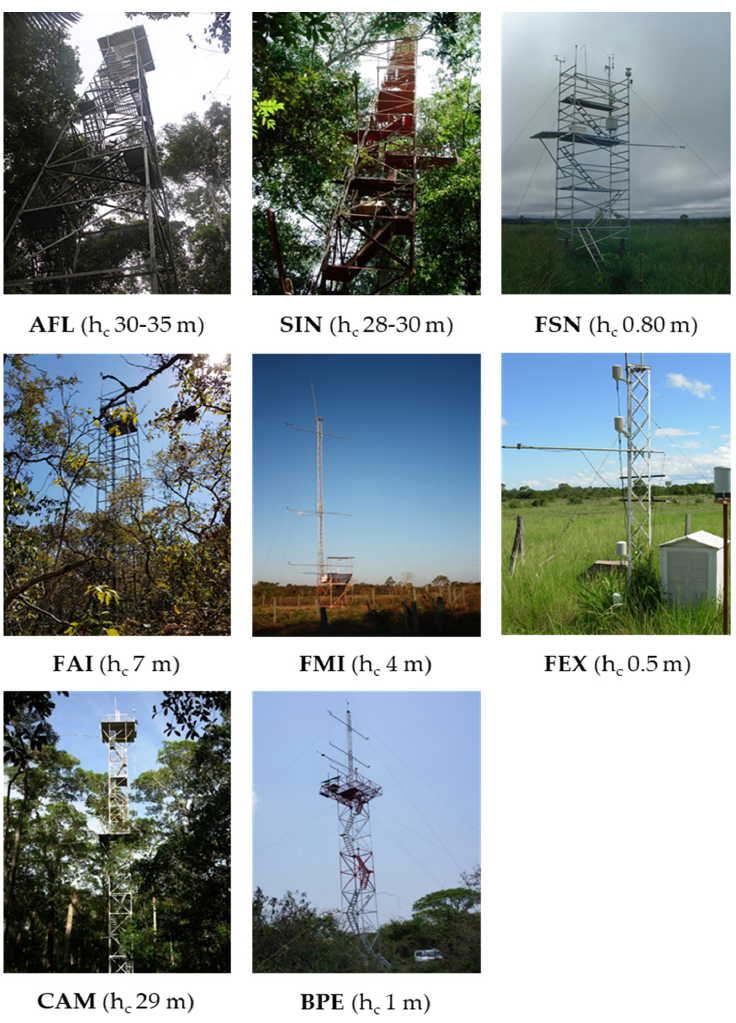
Figure 2. The Flux towers and the canopy height (h c ) at the eight study sites AFL, SIN, FSN, FAI, FMI, FEX, CAM, and BPE.